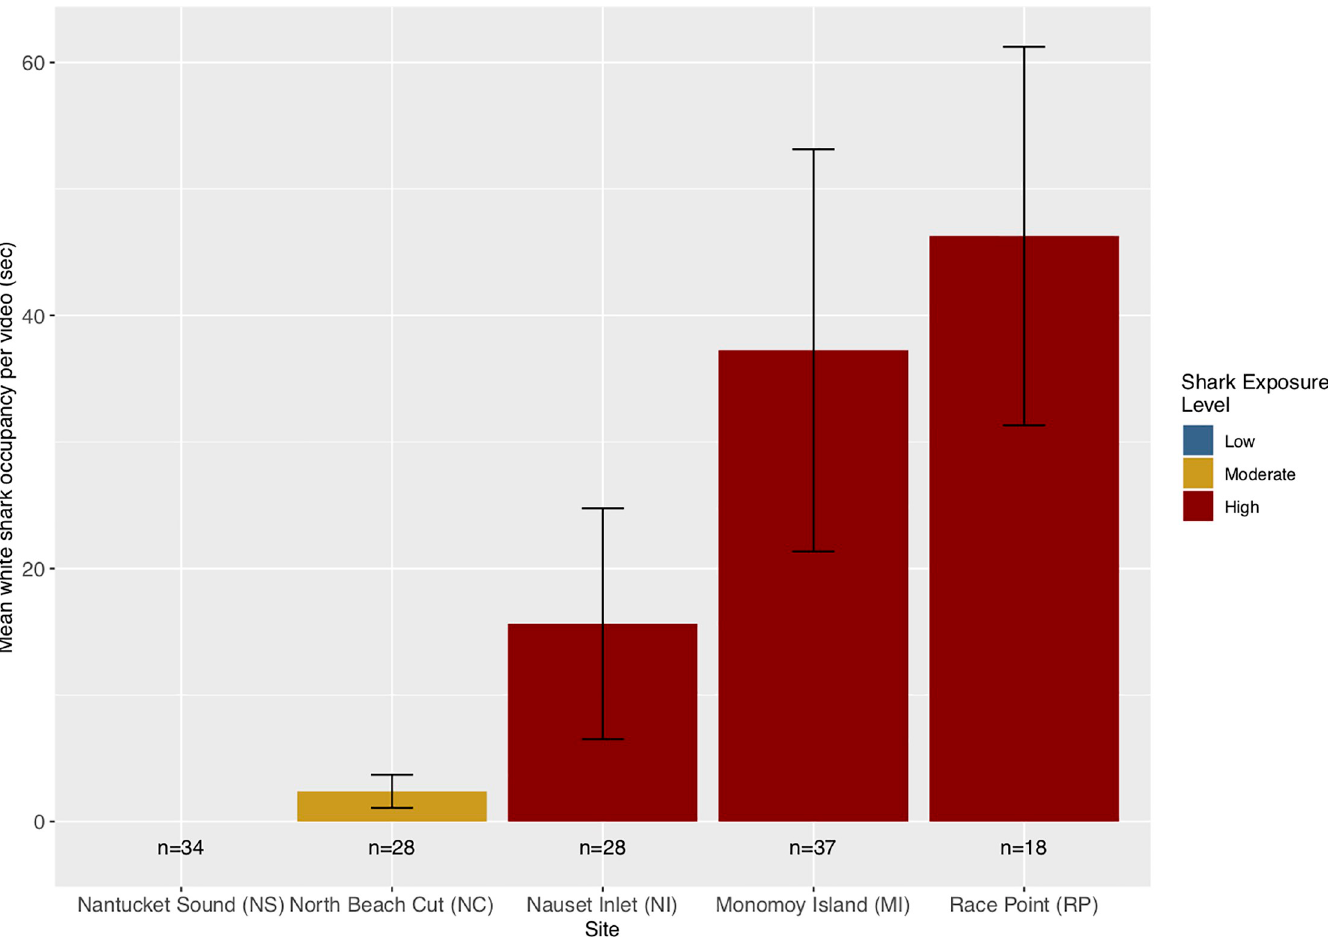
Fig 3. Shark occupancy. Normalized mean occupancy (seconds +/- SE) of white sharks in frame during 60-minute recordings at each site. Colored bars indicate shark exposure levels used for statistical analysis. The total number of deployments at each site is indicated beneath each bar.